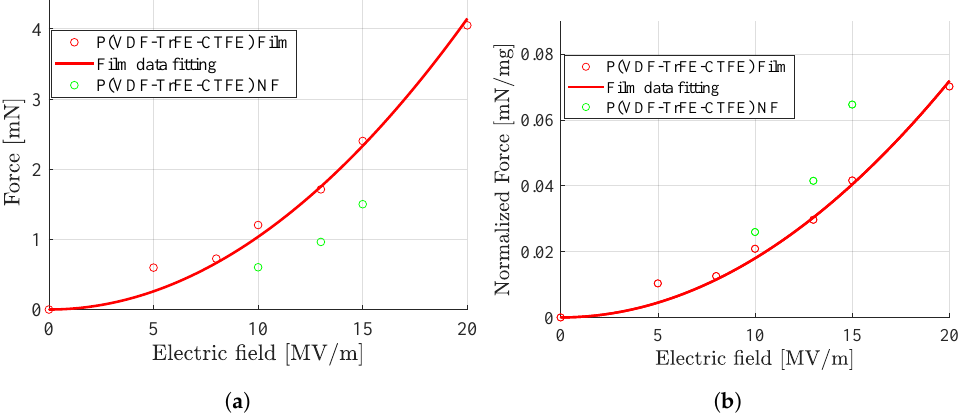
Figure 11. Maximum contraction forces registered at steady state (i.e., after ∼ 10 s) in the uniaxial load test for the P(VDF-TrFE-CTFE) film and the P(VDF-TrFE-CTFE) nanofiber (NF) mat for different applied electric fields. ( a ) Maximum contraction forces. ( b ) Maximum normalized contraction